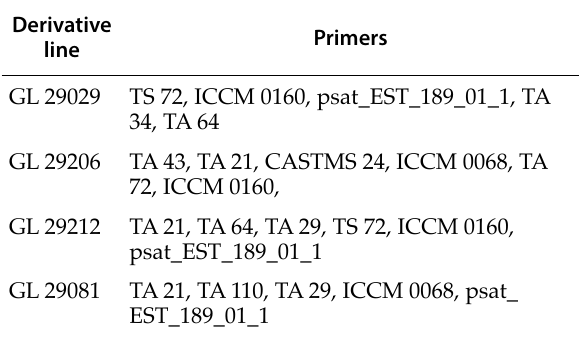
Table 4. SSR primers displaying Cicer pinnatifidum 188 spe - cific segments in four AB and BGM resistant derivative lines .